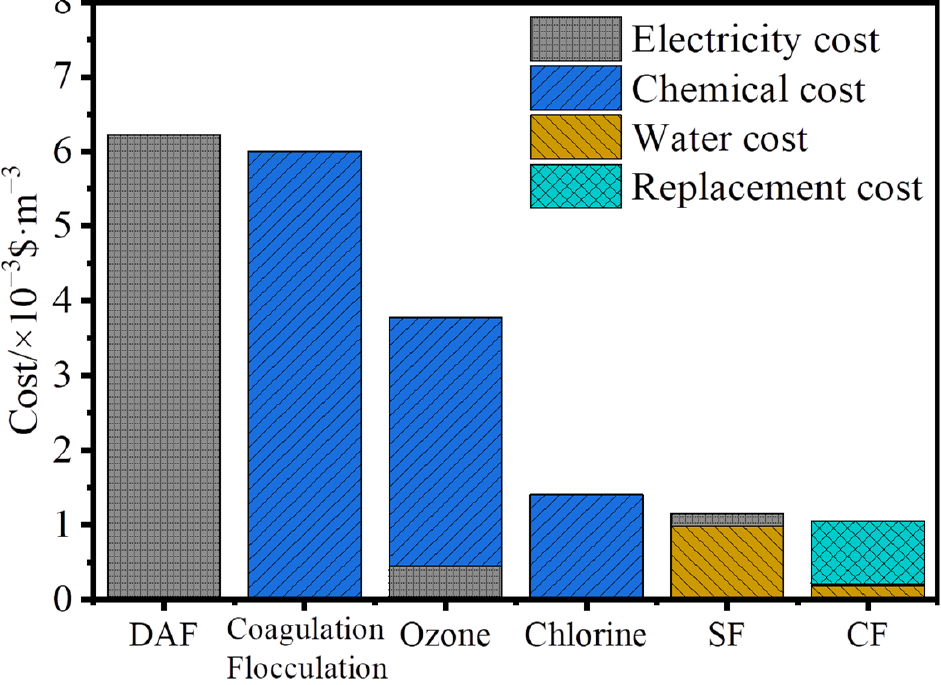
Figure 2. Components of the individual unit processes in the water plant; SF is sand filtration, CF is activated carbon filtration, and activated carbon is designed to be replaced every 5 years.